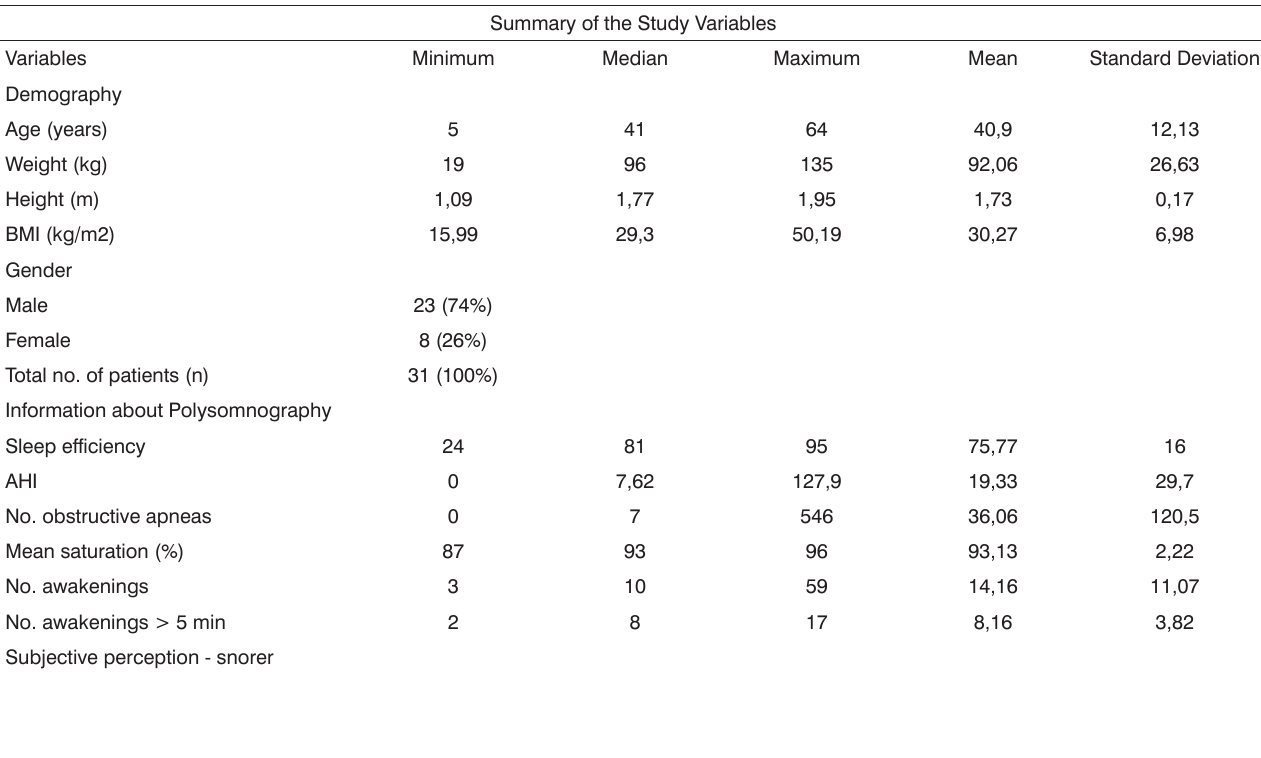
Summary of the Study Variables